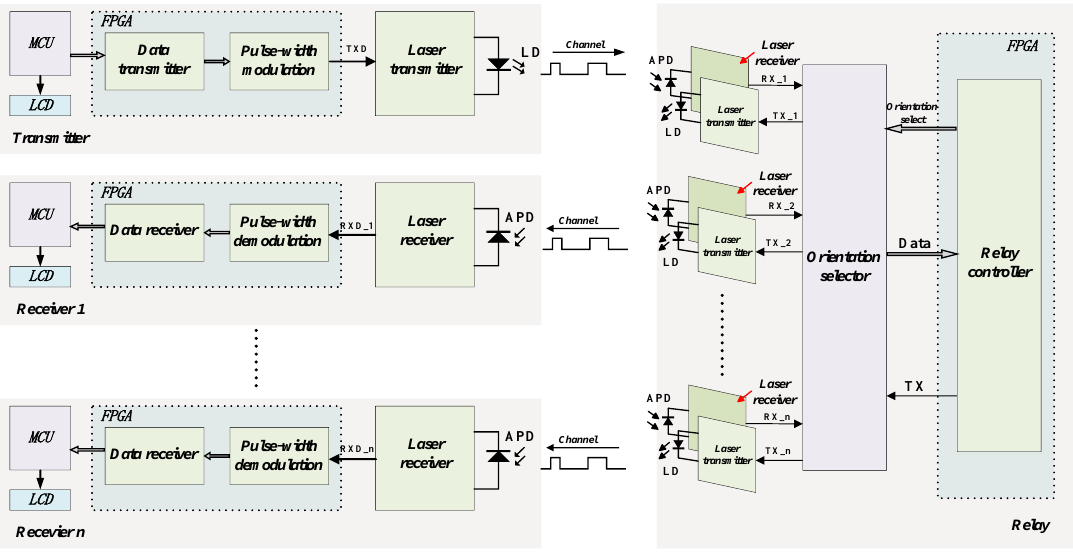
Figure 7. Hardware composition block diagram of a point-to-multipoint free-space optical communication system.